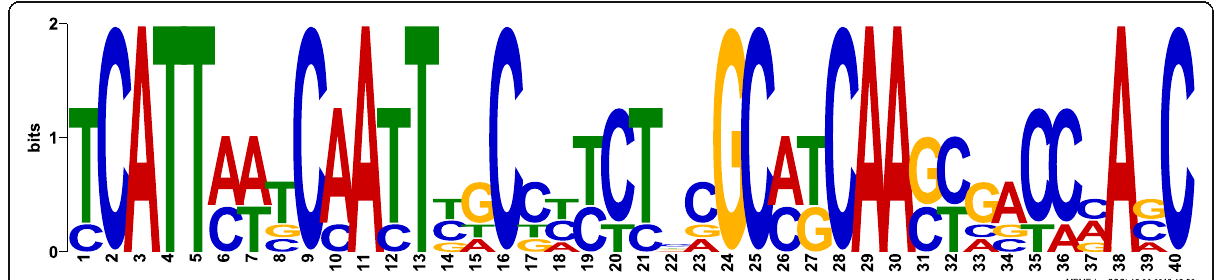
Fig. 4 Shared motif in the promoter sequence region of several P. sojae PL3-coding genes. The motif was identified by MEME-Suite analysis of aligned nucleotide sequences, up to 500bp upstream of the transcription start site for each PL3-coding gene. Five, out of eleven genes (XM_009532098.1, XM_009522992.1, XM_009523712.1, XM_009526562.1, and XM_009526401.1), contained this conserved motif, and its presence correlated with observed increases in transcriptional activity during pathogenicity. Size of base indicates relative level of conservation in the examined